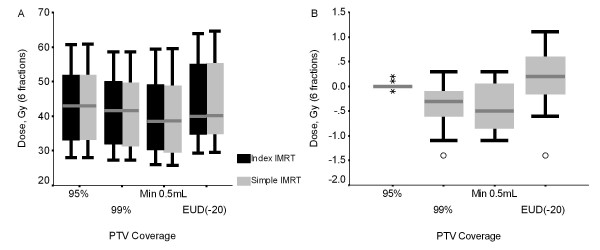
Nominal PTV dose for the index and simple IMRT plans showing the median, interquartile range (box), and range (whiskers or stars (outliers)) of doses for PTV D95, PTV D99 and PTV EUD (-20) (A) and differences of dose for index and simple IMRT.